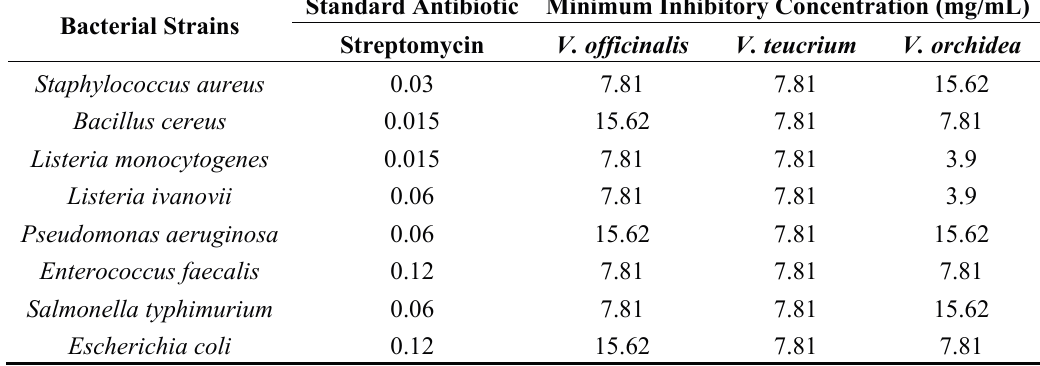
Table 6. Minimum inhibitory concentration (MIC) of V. officinalis , V. teucrium and V. orchidea extracts and streptomycin against bacterial strains tested with the microdilution